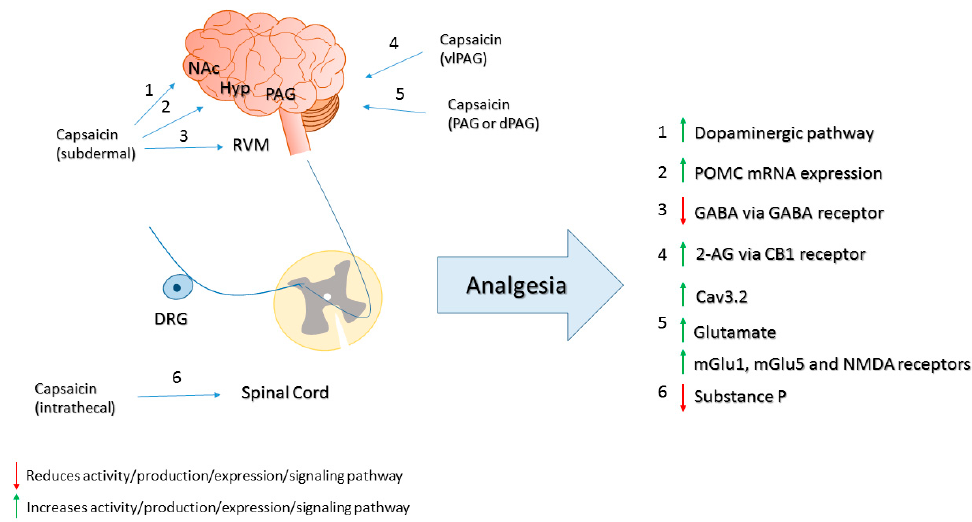
Figure 4. Supraspinal mechanisms of capsaicin-induced analgesia. Subdermal injection of capsaicin produces analgesia by modulating dopaminergic pathway in the NAc (1) [96], opioid pathway in the hippocampus (2) [98], and GABAergic activity in the RVM (3) [96,97]. In addition, vlPAG injection of capsaicin activates endocannabinoid pathway (4) [99], and dPAG by modulating glutamate signaling pathway (5) [100]. Intrathecal injection of capsaicin depletes substance P and also produces analgesia (6) [101–103]. DRG: dorsal root ganglion; NAc: nucleus accumbens; Hyp: hippocampus; RVM: rostral ventromedial medulla; PAG: periaqueductal gray; vlPAG: ventrolateral periaqueductal gray; dPAG: dorsal periaqueductal gray;